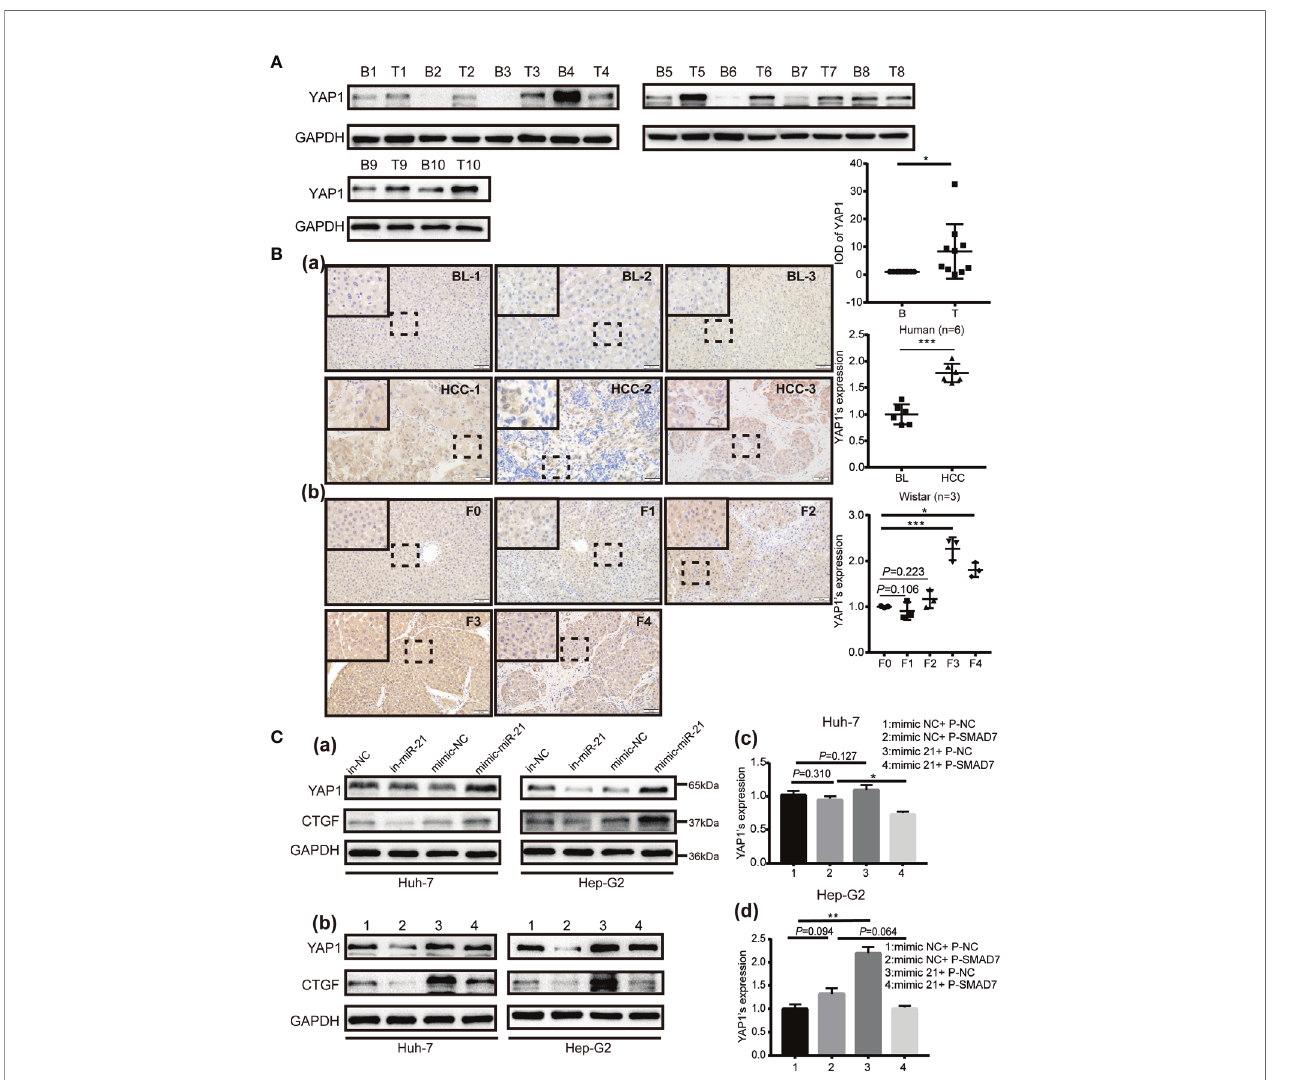
FIGURE 5 | YAP1 is upregulated in HCC and is facilitated by miR-21-3p via SMAD7 inhibition. (A) Western blotting was performed to show YAP1 expression in human HCC (T: tumor) and corresponding background liver tissue (BL) (B: background). Photographs are detailed alongside. (B) YAP1 expression in HCC, BL (a) and different liver disease stages in a rat model (b) was evaluated via immunohistochemical staining (magni fi cation 400×). Six paired human and three rat samples in each group were statistically analyzed. (C) Western blotting of YAP1 48 h after transfection with miR-21-3p inhibitors or mimics in Huh-7 and Hep-G2 cells (a); protein (b) and mRNA (c, d) YAP1 expression after plasmid-SMAD7 transfection, with or without miR-21-3p mimics. Experiments were performed separately in triplicate. *P < 0.05, **P < 0.01; ***P <